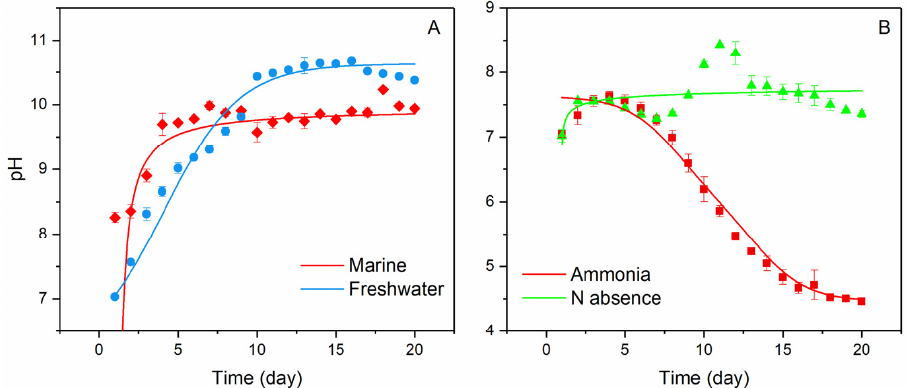
Figure 1. pH changes in different culture environments over 20 days of incubation, showing rising pH with time in nitrate condition for both marine and freshwater communities and ( A ) declining pH over time in ammonia condition as well as the relatively stable pH, when N is absent in freshwater ( B ). Error bars represent range of the measurements (n = 3).